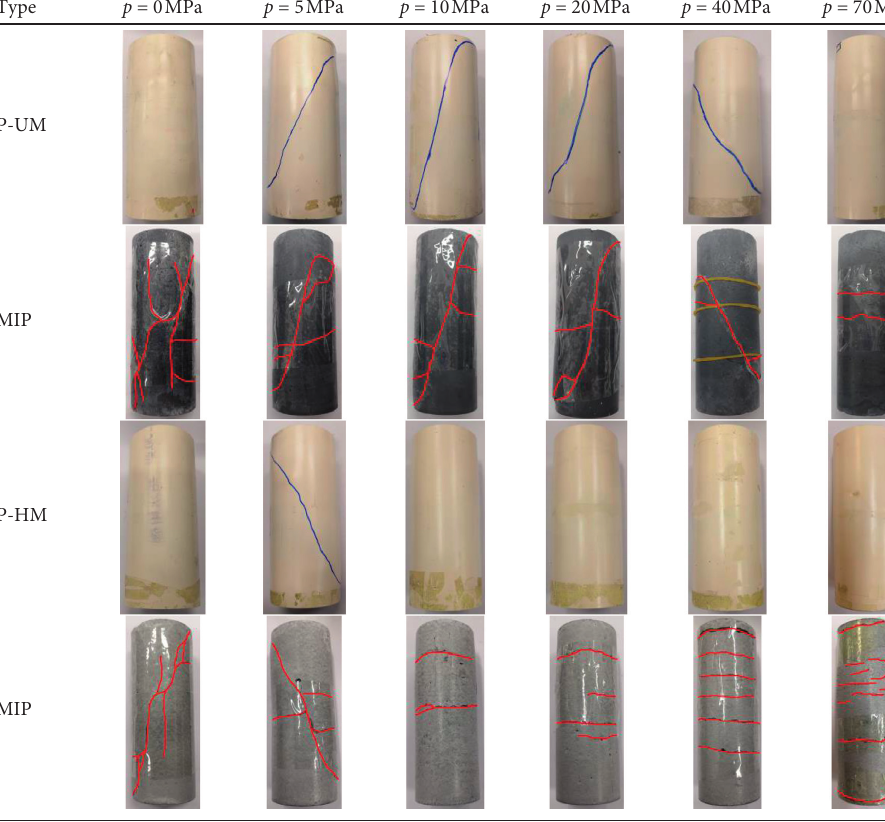
Figure 8: Failure modes of specimens tested by PMM under different confinements. Notes . MIP: mortar specimen inside the PVC